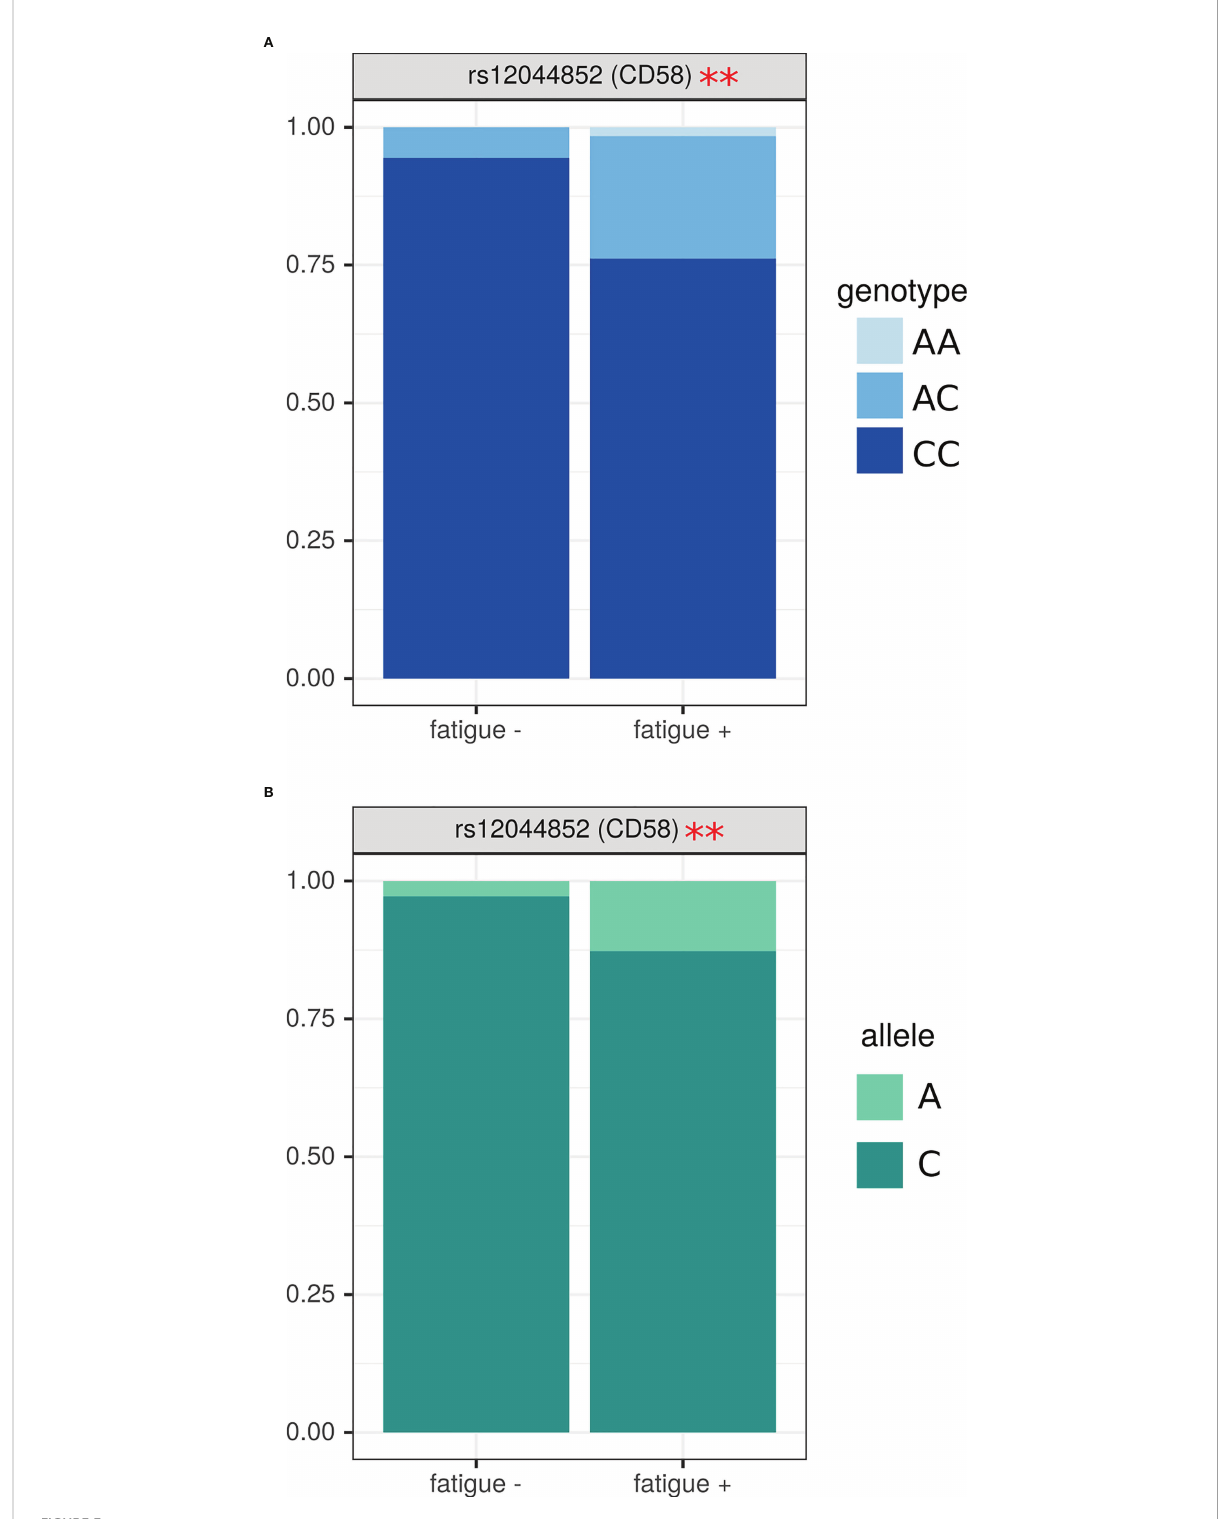
FIGURE 3 Analysis of SNPs genotype and allele frequency based on presence of fatigue in MS. (A) – genotypes, (B) – alleles. Data is presented as proportion of representation of genotype/allele. There were 151 MS patient samples used for the analysis. The analysis was done using Fisher ’ s exact test. ** -